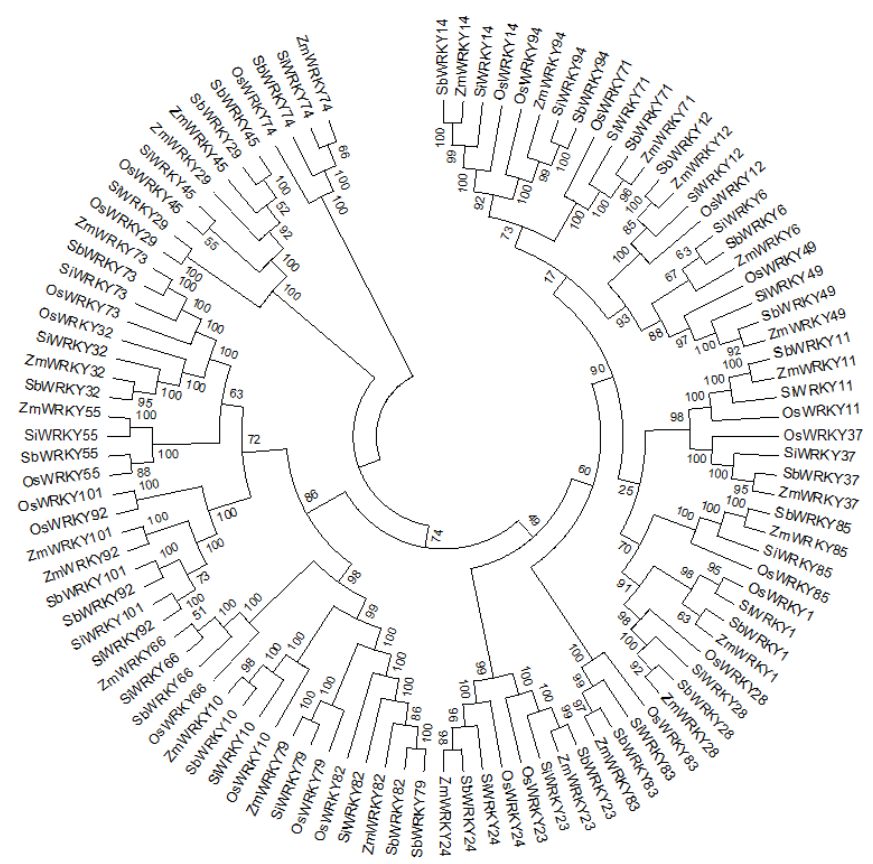
Figure 4. Phylogenetic relationships of 26 potential OsWRKY genes of O. sativa, S. italica, S. bicolor, and Z. mays . The amino acid sequences were aligned by ClustalW at the MEGA v 7.0 program with the unrooted maximum likelihood method. The evolutionary tree was constructed with bootstrap confidence values from 1000 iterations.